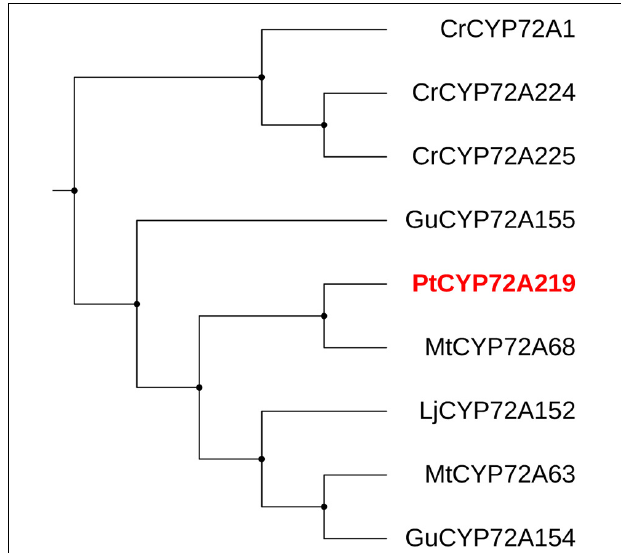
FIGURE 8 | The phylogenetic tree analysis between PtCYP72A219 and eight known CYP72As participated in terpenoid metabolism. The CYP72As from different species were obtained from UniProt database: CrCYP72A1 (No. Q05047), CrCYP72A224 (No. U5NE19), CrCYP72A225 (No. W8JWW3), GuCYP72A154 (No. H1A988), GuCYP72A155 (No. H1A989), MtCYP72A63 (No. H1A981), MtCYP72A68 (No. Q2MJ19), LjCYP72A152 (No.